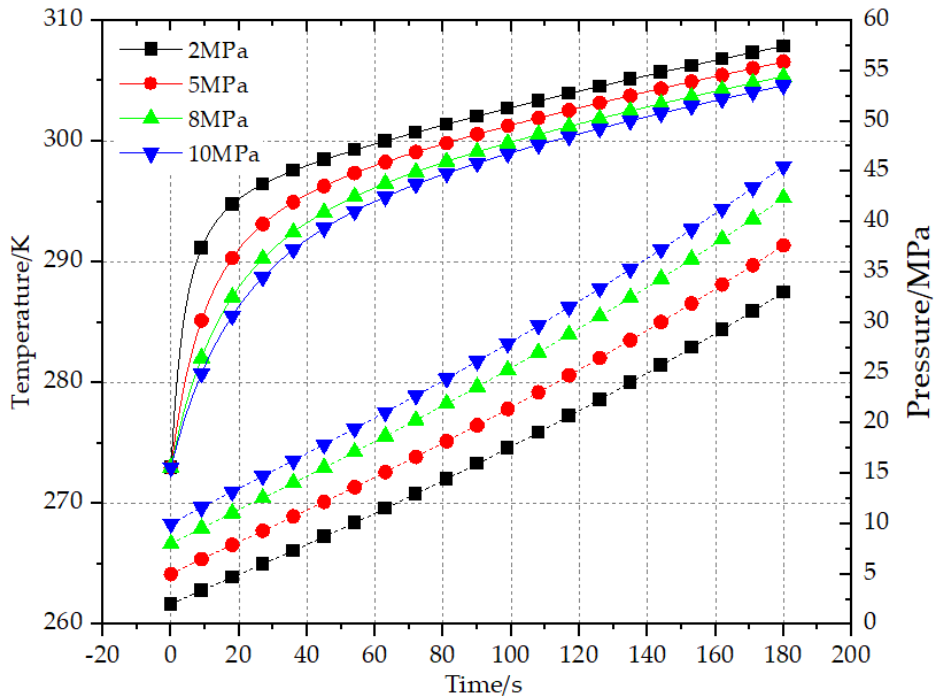
Figure 8. Effect of initial pressure on the temperature evolution.